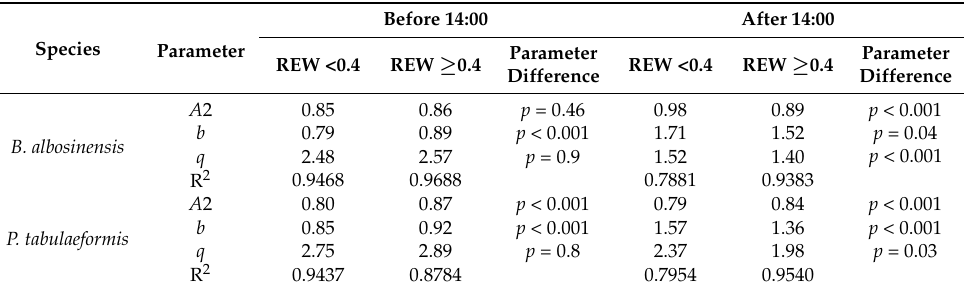
Table 2. Results of regression analyses for the relationships of the normalized Sap flux density ( F d ) in response to vapor pressure deficit ( VPD ) in the daytime hours for respective species in Figure 7. The datasets of the normalized F d and VPD covered periods with relative extractable water (REW) <0.4 and REW ≥ 0.4 at different times in August, respectively. The e logarithmic function (DoseResp